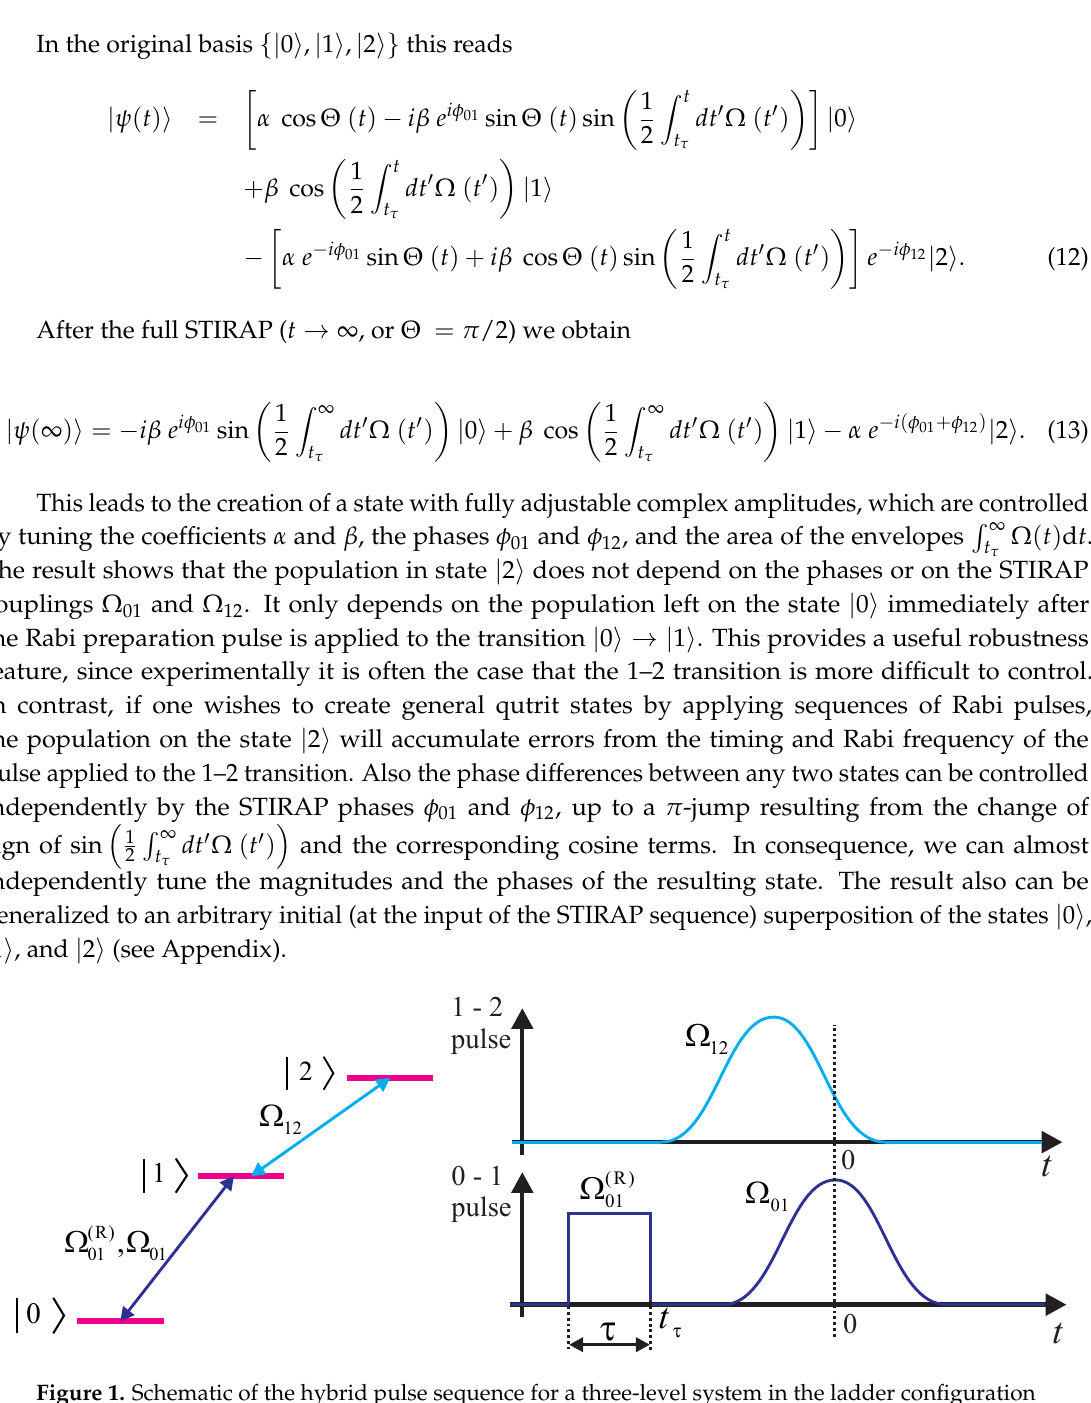
Figure 1. Schematic of the hybrid pulse sequence for a three-level system in the ladder configuration and with the two transitions driven resonantly by two fields. First, a superposition between state | 0 (cid:105) and state | 1 (cid:105) is created by a nonadiabatic Rabi pulse Ω ( R ) (for simplicity taken as a square pulse). 01 Then a stimulated Raman adiabatic passage (STIRAP) sequence is applied, with a pulse on the 1–2 transition (with coupling strength Ω 12 ) followed by another pulse on the 0–1 transition (with coupling strength Ω 01